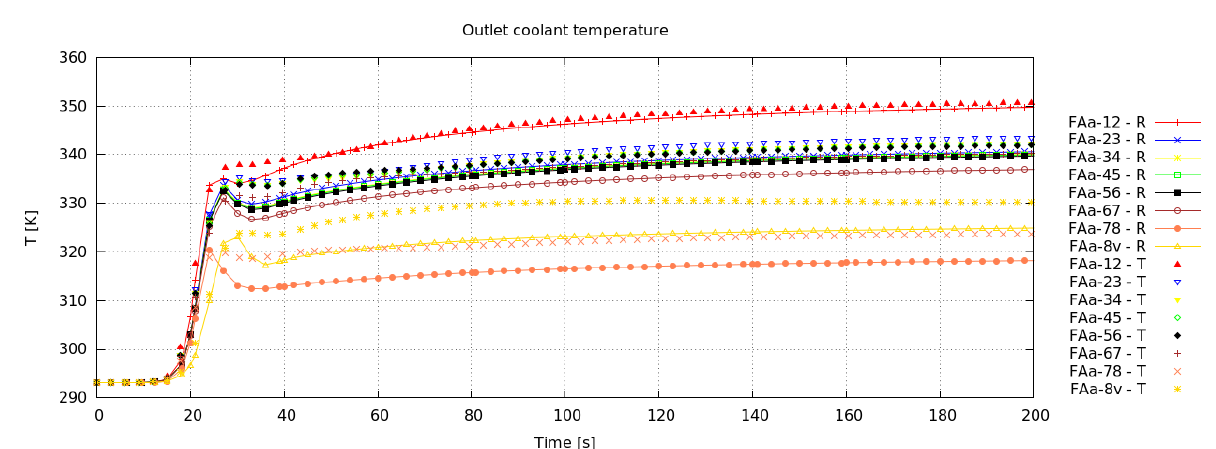
Figure 6. Outlet coolant temperature during step increase of reactivity accident by 0.7 β